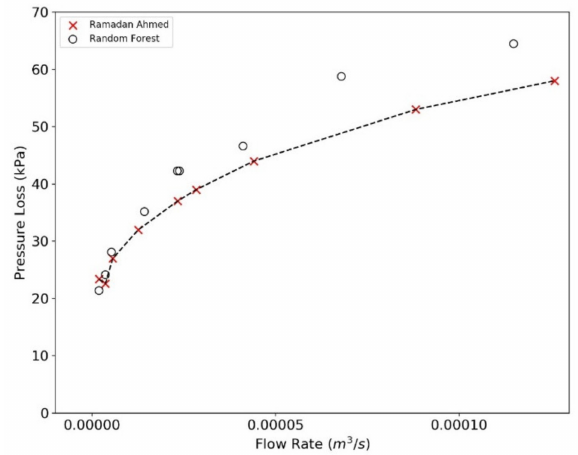
Figure 18. Comparative analysis of the theoretical solution by Ahmed et al. [19] and the Random Forest.